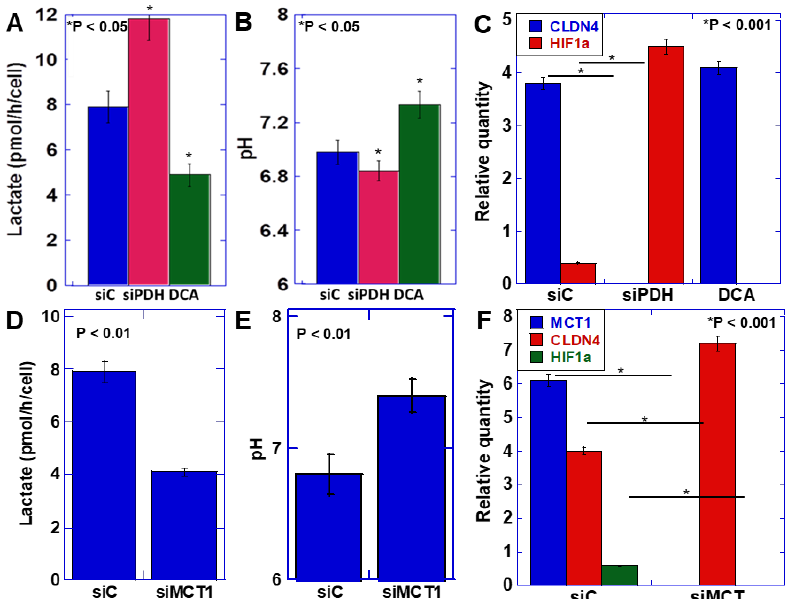
Figure 3. Effect of lactate on the EMT phenotype in HSC4 OSCC cells. ( A – C ) Effect of knockdown of pyruvate dehydrogenase (PDH) or inhibition of PDH kinase by dichloroacetate (DCA) on extracellular lactate ( A ), extracellular pH ( B ), and mRNA expression of EMT-associated genes measured by quantitative PCR ( C ) in HSC4 cells. ( D – F ) Effect of knockdown of monocarbonate transporter (MCT)1 on extracellular lactate ( D ), extracellular pH ( E ), and mRNA expression of EMT-associated genes measured by quantitative PCR ( F ) in HSC4 cells. Error bar, standard deviation tested by Student’s t -test in three independent trials. siPDH, siRNA for PDH; siMCT1, siRNA for MCT1.